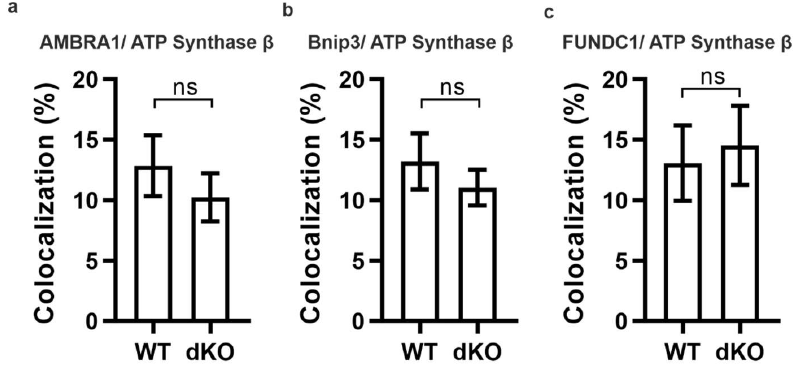
Figure A1. Representative graphical data from double-staining of AMBRA1 (a, p = 0.4), Bnip3 (b, p = 0.4) and FUNDC1 (c, p = 0.7) with ATP synthase β. There was no statistically significant difference in the colocalization analysis between one-year-old WT and dKO. ns—Nonsignificant.